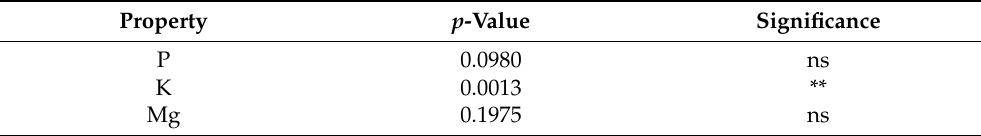
Table 2. Influence of foliar fertilization on the content of phosphorus, potassium and magnesium in leaves. Property p -Value Significance P 0.0980 ns K 0.0013 ** Mg 0.1975 ns ns not significant; ** significant at 0.01 level.